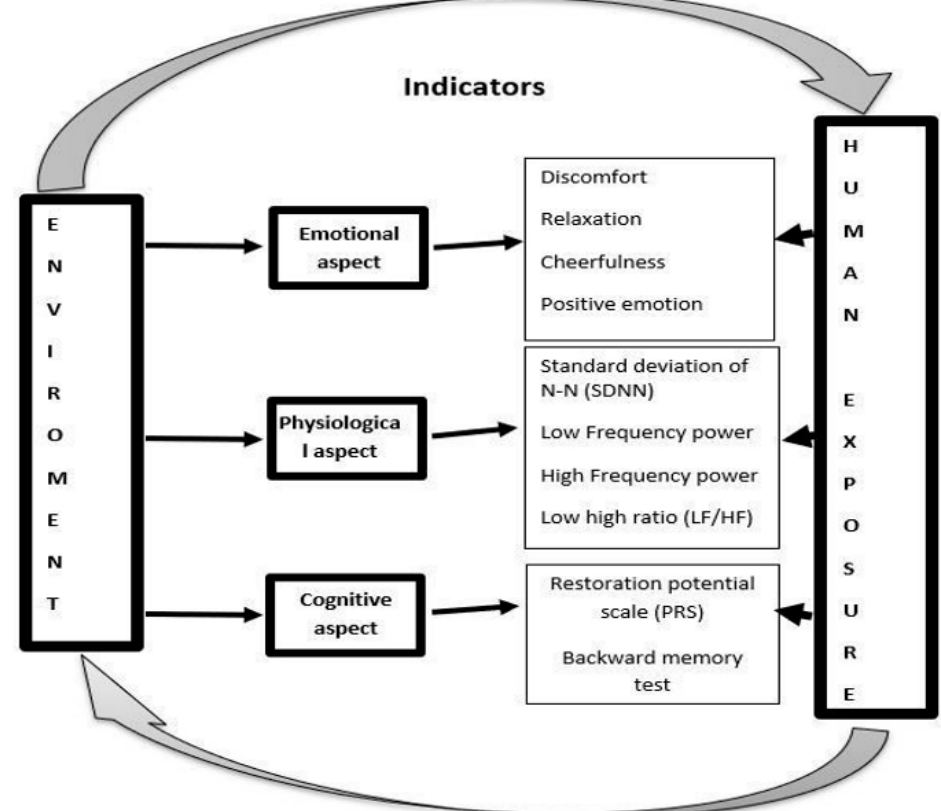
Figure 1. The indices of a general model of environmental stress.